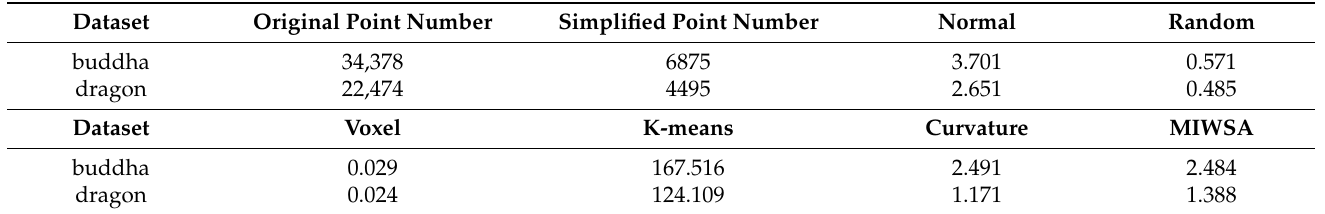
Table 5. Point numbers and running time for datasets Samp52 and Samp53 (unit: s).